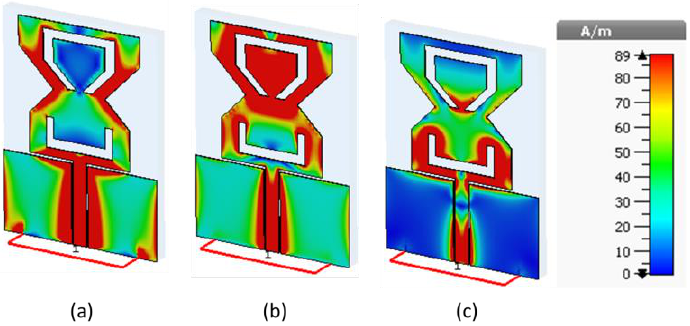
Figure 4. Surface current distribution at specified frequencies; ( a ) 28 GHz, ( b ) 38 GHz, and ( c ) 60